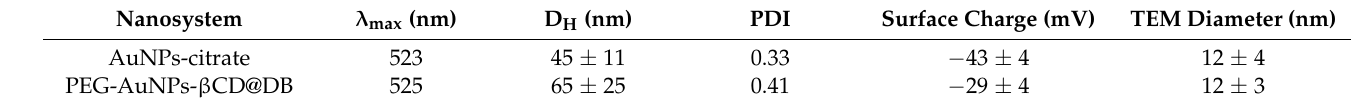
Figure 4. ( a ) UV-vis spectra of AuNPs stabilized with citrate: βCD @DB and PEG- βCD @DB. HR-TEM of the PEG-AuNPs- βCD @DB system: ( b ) wide view and ( c ) zoom-in. Table 2. Wavelengths of the maximum absorbance (λ max ), hydrodynamic diameter (D H ), polydispersity index (PDI), surface charge, and diameter according to TEM for AuNPs with different stabilizers.